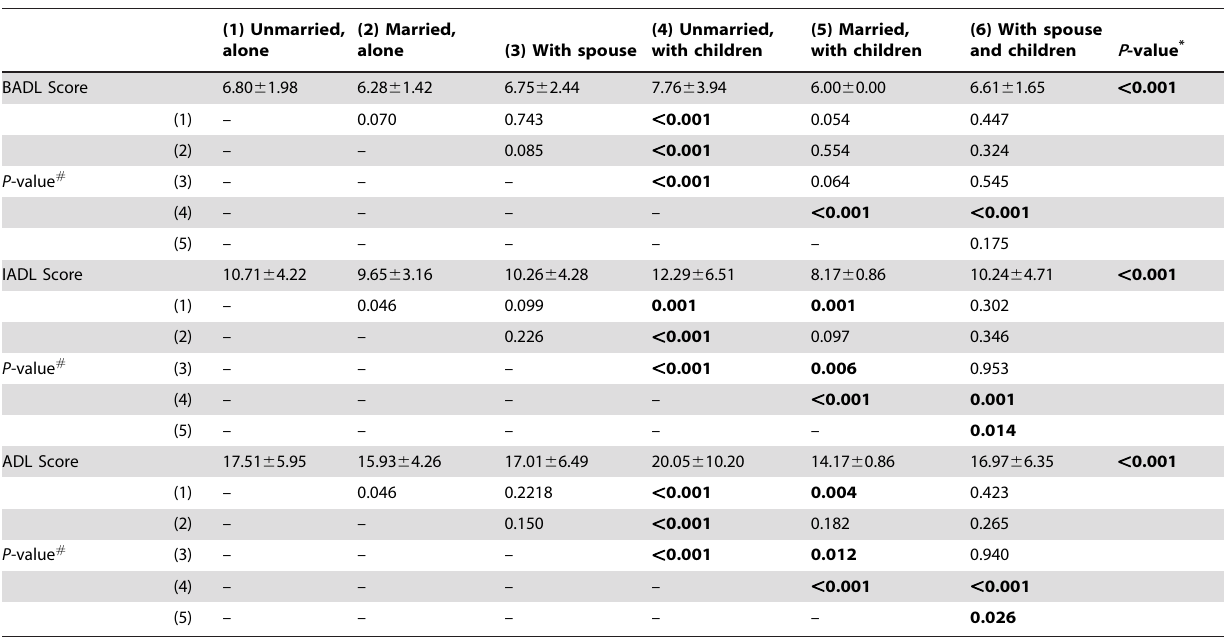
Table 2. Distribution and difference of functional disability by living arrangement.